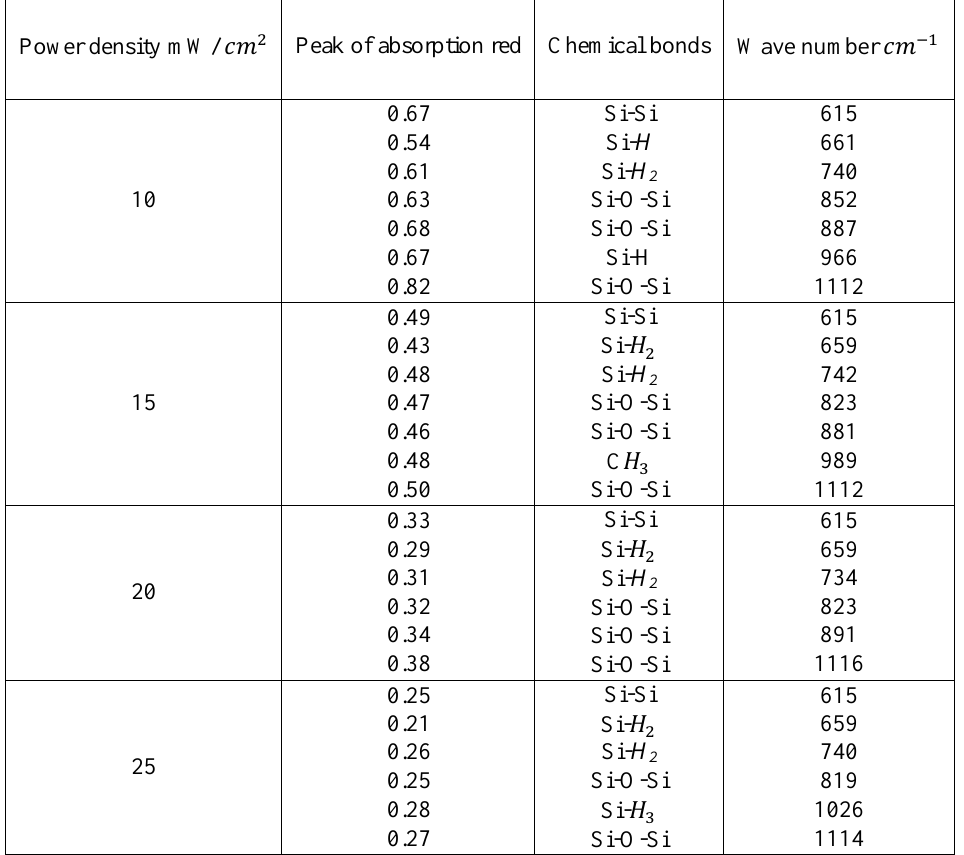
Table 1: Peak position of chemical bonds of the prepared PSi with different laser intensities; a)10, b)15, c) 20, and d) 25 mw/ cm 2 at a fixed etching current of about 8 mA/cm 2 8 and with etching time of 20 min.